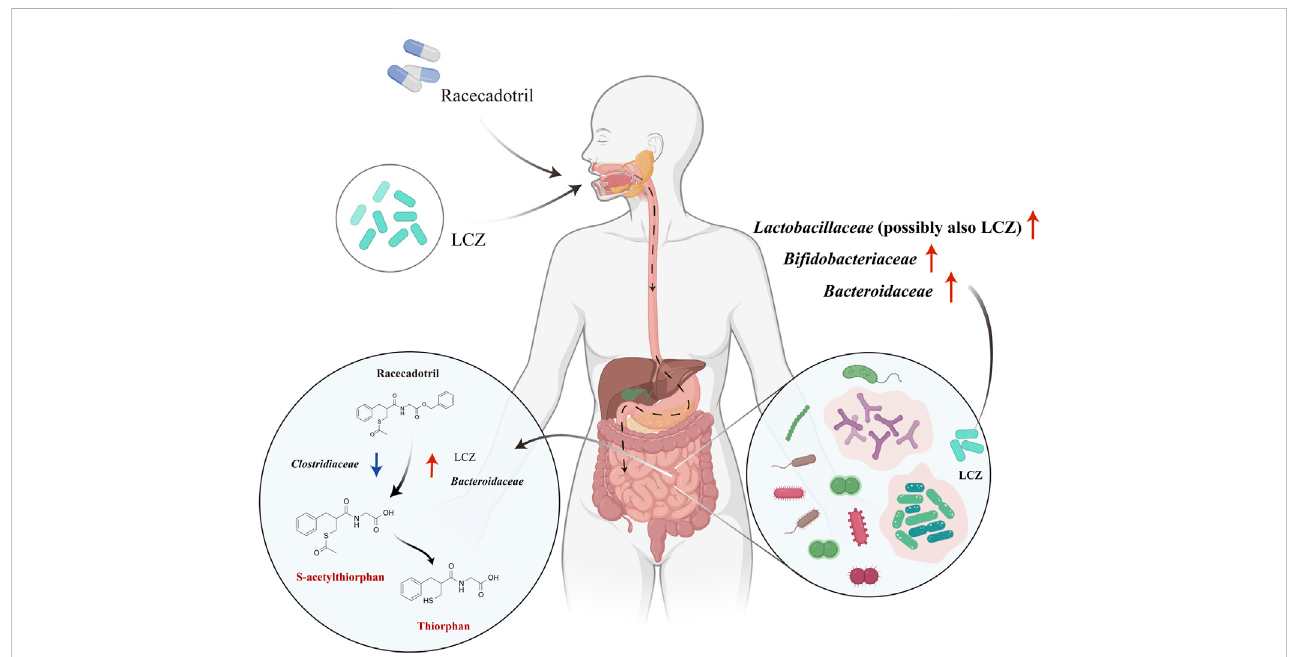
FIGURE 5 Proposed mechanisms of in vivo racecadotril degradation via direct metabolic action of L. casei Zhang (LCZ)and interactions between LCZ and host gut microbiome. Red arrows in the right circle indicate the effects of LCZ on the gut microbial communities. Arrows in the left circle indicate the effects of Bacteroidaceae / Clostridiaceae/ LCZonthemetabolism ofracecadotril (Redarrows indicatepromotion,bluearrows indicate inhibition). Chemicals markedin red are metabolites of racecadotril veri fi ed by targeted